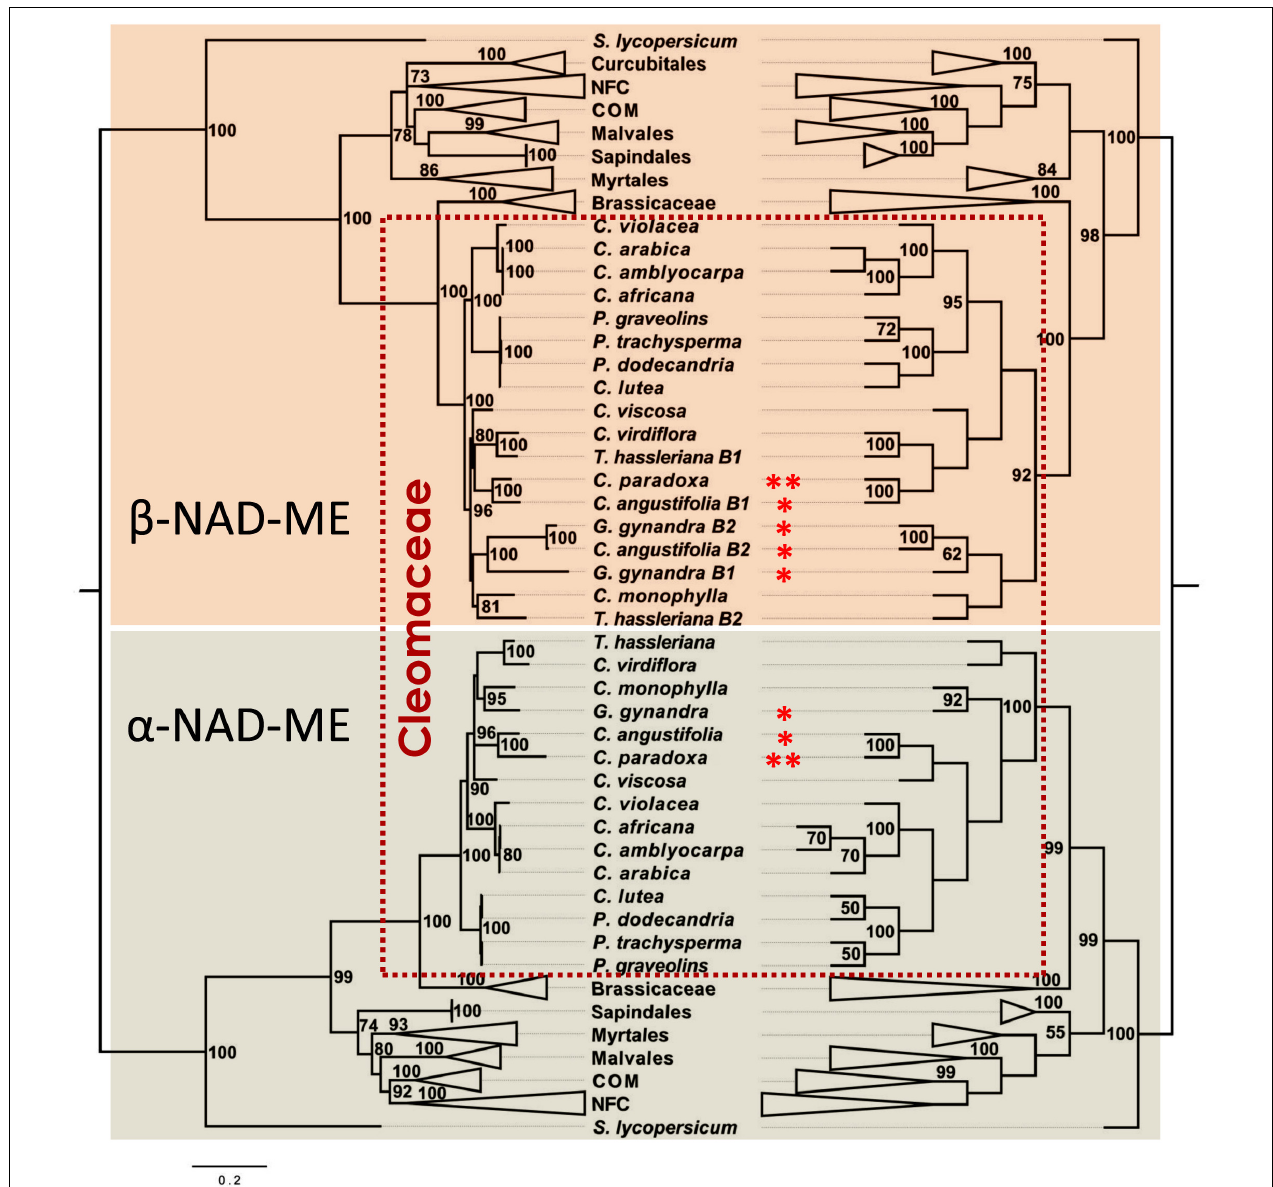
FIGURE 4 | Evolutionary history of NAD-ME genes in Cleomaceae deduced from third position of the codons. Bayesian (left) and Maximum Likelihood (right) phylogenetic tree of NAD-ME of the Rosid lineage. Most of the clades are compressed and designated by their Order or Family names. BPP and MLB values higher than 70 and 50%, respectively, are given next to the branches. In the BI analysis, the tree is drawn to scale with branch lengths measured in the number of substitutions per site. In the ML analysis, the bootstrap consensus tree (dendogram) inferred from 2,000 replicates is taken to represent the evolutionary history of the taxa, in which the partitions reproduced in less than 50% of the bootstrap replicates are collapsed. In both analyses, the best-fit substitution model was a GRT + G (3.70) model involving 124 nucleotide sequences and a total of 497 positions in the final dataset. ∗ and ∗∗ indicate C 4 and C 3 –C 4 photosynthetic metabolism, respectively. Solanum lycopersicum NAD-MEs coding sequences were used as out groups. The full trees are available in Supplementary Data 6 and Supplementary Data 7